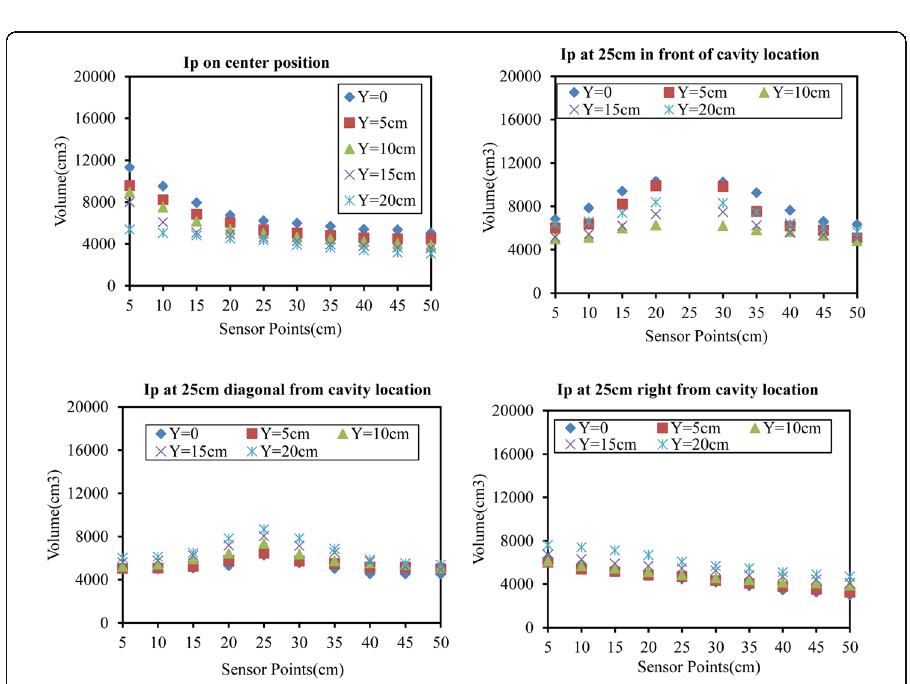
Fig. 22 Volume analysis for cavity size 5 × 5 ×